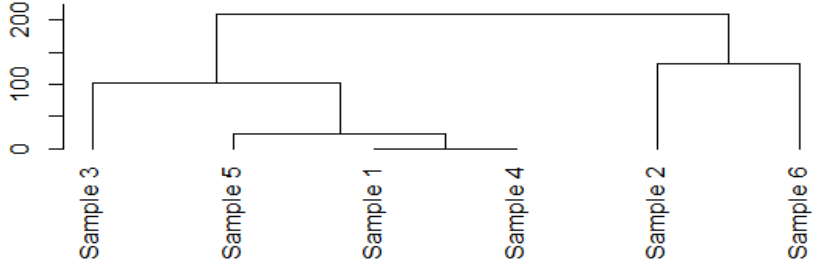
mushroom Figure 5. The dendrogram represents clustered toxic fingerprints based on the MTC values of the six mushroom samples .